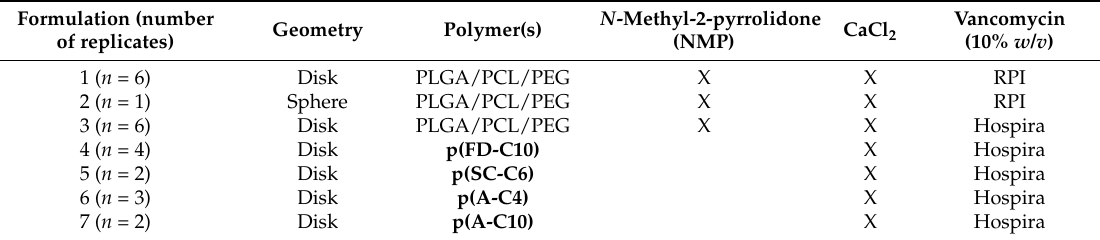
Table 1. Formulations presented in this manuscript. The source of vancomycin is noted in the last column. All formulations had the same ratio of components in the final formulation. The first two letters of the custom polymers (4–6) indicate the amino acid mimic (A—Alanine, F—Phenylalanine, D—Aspartic acid), whereas the second part denotes the number of carbon atoms in the diacid. The polymer p(SC-C6) contains two non-natural pendant